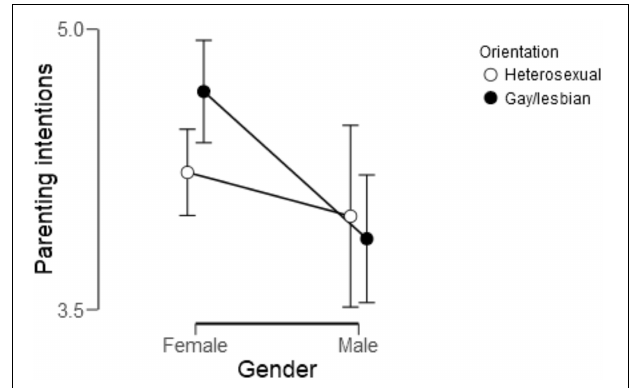
FIGURE 1 | The strength of parenting intentions among gay men, lesbian women and heterosexual men and women. Points represent group averages, n = 281. Responses were on 6-point Likert scale with higher scores indicating a stronger intent to become a parent.